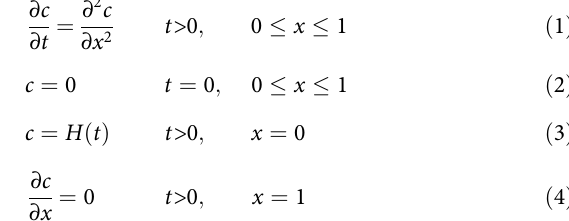
(Fig. 2o – r). The K values of the two-sided OHSA decreased symmetrically from the outer layers to the inner layers in two directions and that of one-sided OHSA decreased sequentially from the outermost layer to the inner layers. The change in trends